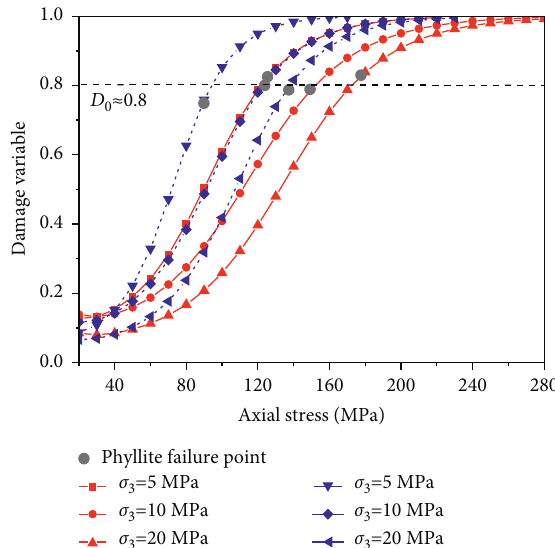
Figure 11: The relationship between the damage variable and axial stress (blue denotes saturated phyllite and red denotes dry phyllite; σ 3 is the confining pressure; D 0 is the critical damage